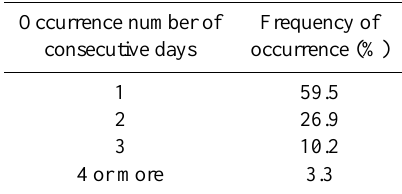
Table 2. Statistical analysis of MSR database overpasses at R´ıo Gal-